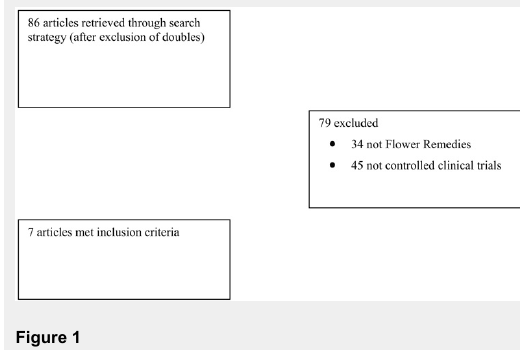
Table 1 Randomised clinical trials of Flower Remedies (Flower Remedies). Reference Study design Jadad